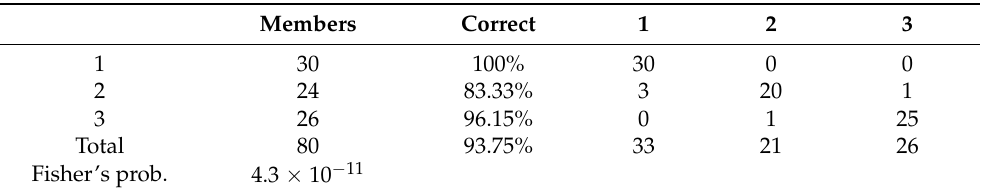
Table 3. Misclassification table from OPLS-DA modeling of the training set, where 1 = Maurolia (Messinia), 2 = Lianolia Kerkyras (Preveza), and 3 = Koroneiki (Preveza). Members Correct 1 2 3 1 30 100% 30 0 0 2 24 83.33% 26 96.15% Total 80 93.75% Fisher’s prob. Table 4. Misclassification table from OPLS-DA modeling of the test set where 1 = Maurolia (Messinia), 2 = Lianolia Kerkyras (Preveza), and 3 = Koroneiki (Preveza). Members Correct 1 2 3 100%